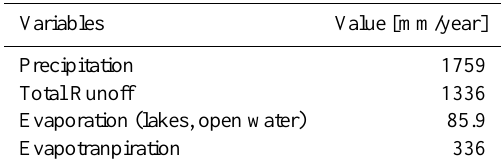
Table 2. Accumulated water per year